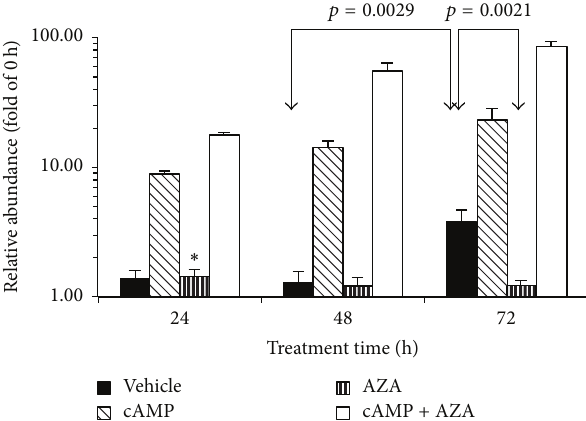
Figure1: CRH mRNArelativeabundanceinBeWocellstreatedwith 8-Br-cAMP (cAMP, 2.5 × 10 −4 molL −1 ) and 5-AZA-dC (AZA, 5 × 10 −6 molL −1 ) for 24h, 48h, and 72 h. The average ± SEM of results of four independent experiments is shown. Significant pairwise differences ( 𝑡 -test) between vehicle-treated and 5-AZA-dC-treated cultures are indicated. Significant pairwise differences involving 8-Br-cAMP-treated cultures and 8-Br-cAMP + 5-AZA-dC-treated cultures are described in the Results. ∗ Significantly higher than 0 h ( 𝑝 = 0.0276 , one-sample, one-sided 𝑡 -test).